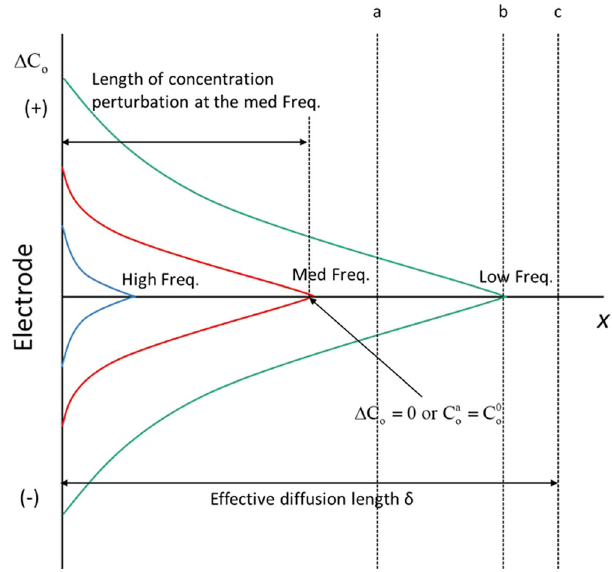
Fig. 4 Concentration perturbation length versus excitation frequency. The diffusion length becomes longer as the excitation frequency becomes lower. Since at low frequency, an ion has longer time to diffusion on one direction. Δ C the change of concentration. (reprinted from ref. 1 . Copyright © 2018, with permission from John Wiley and